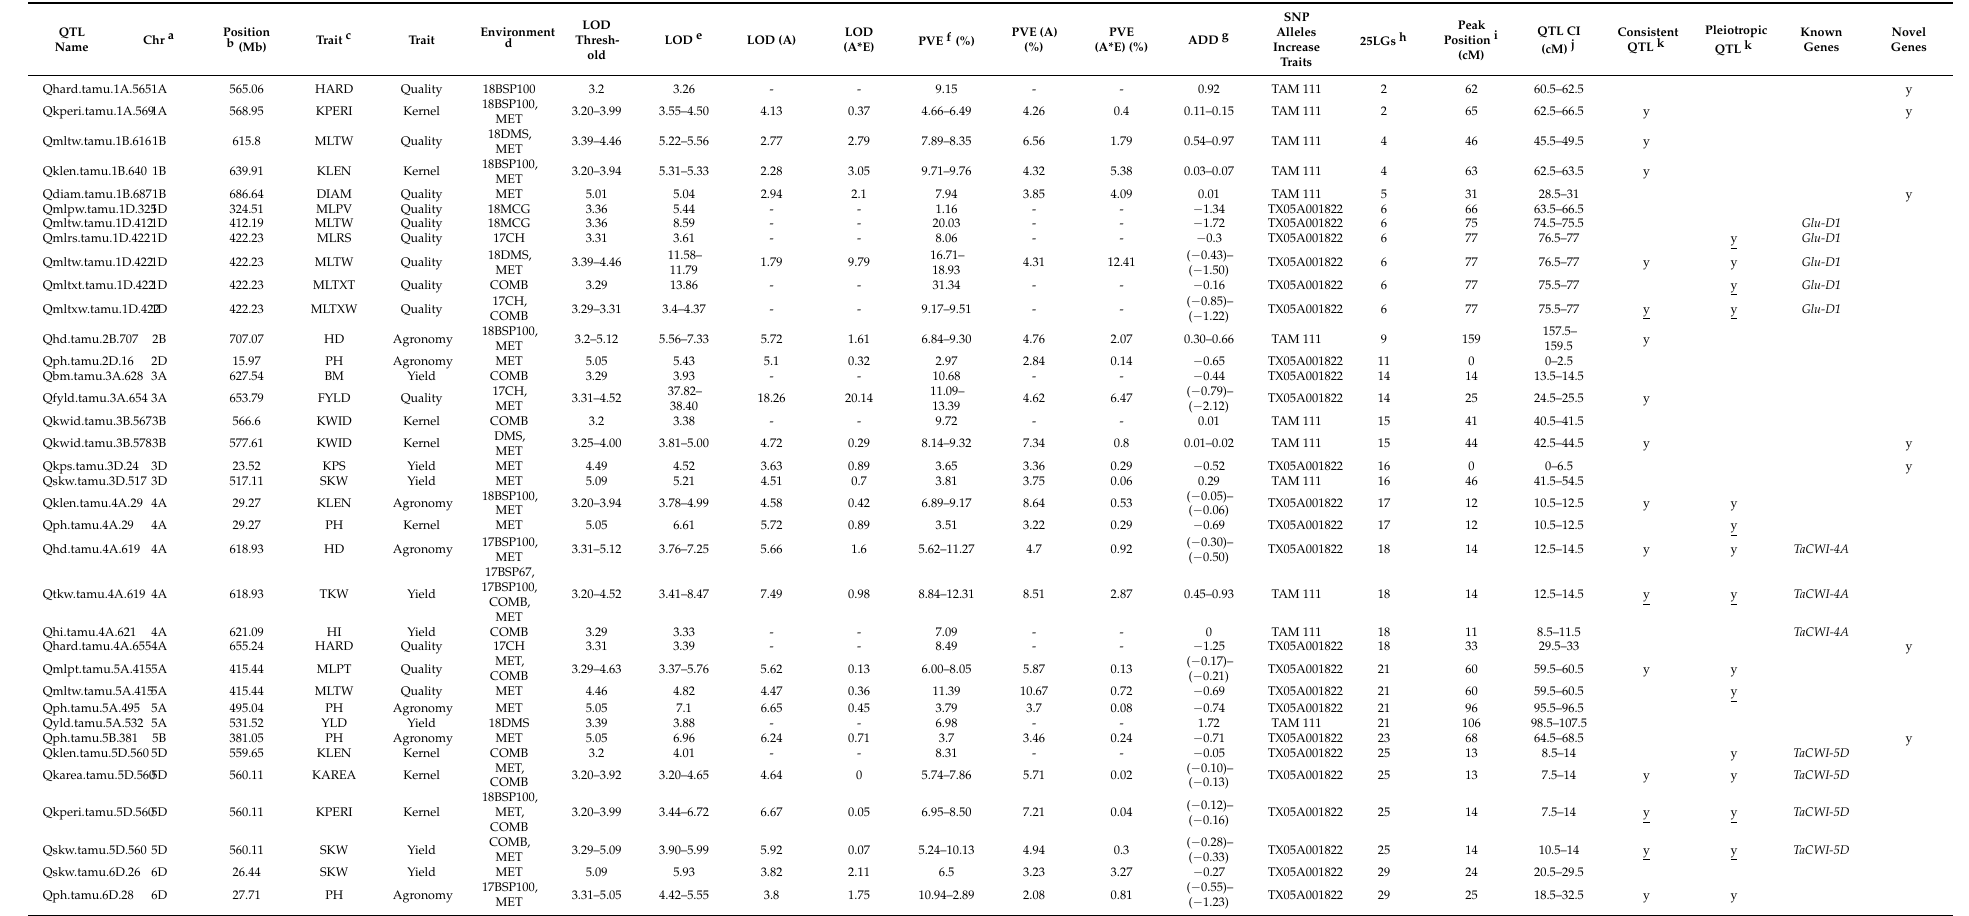
Table 1. Consistent and pleiotropic QTLs for end-use quality, agronomical, yield components, and kernel-related traits identified in the TAM 111/TX05A001822 population by individual and multiple environment